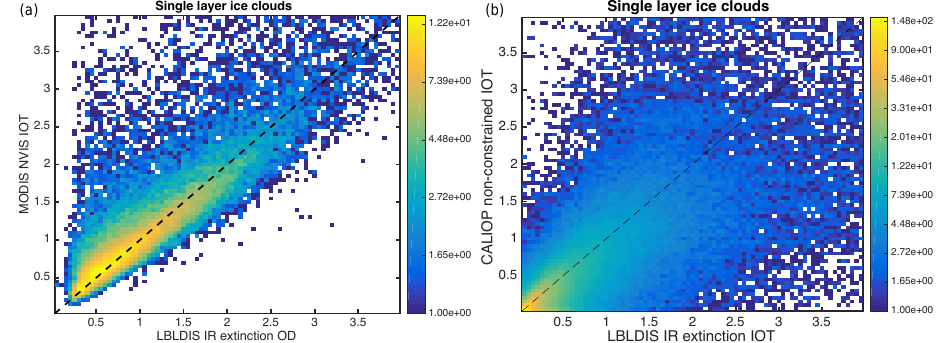
Figure 7. The joint histogram comparing the MODIS C6 IOT with the reference IOT retrieval (a) . Note the significant improvement in the agreement resulting from the change to severely roughened aggregated columns. The CALIOP non-constrained IOT using a modified lidar ratio of 32 is compared to collocated IR MODIS retrieved IOT in panel (b) . Note the significant improvement in the non-linear bias compared to Fig.